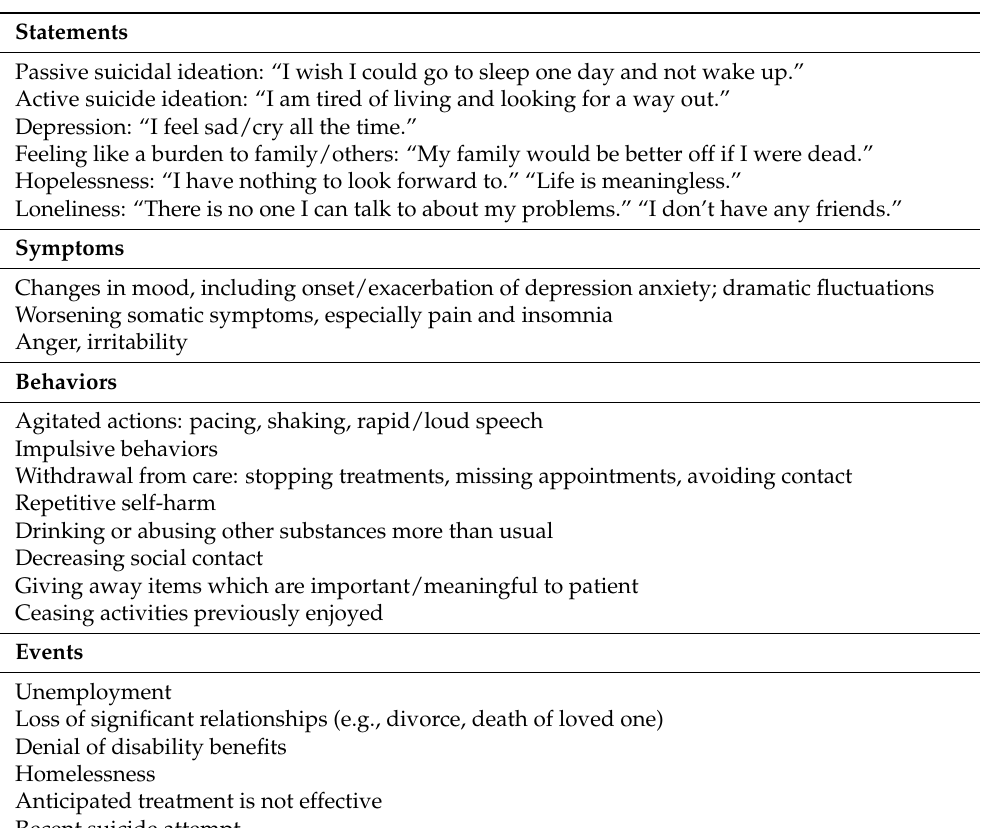
Table 2. Concerning statements, symptoms, behaviors, and events should prompt clinicians to assess for